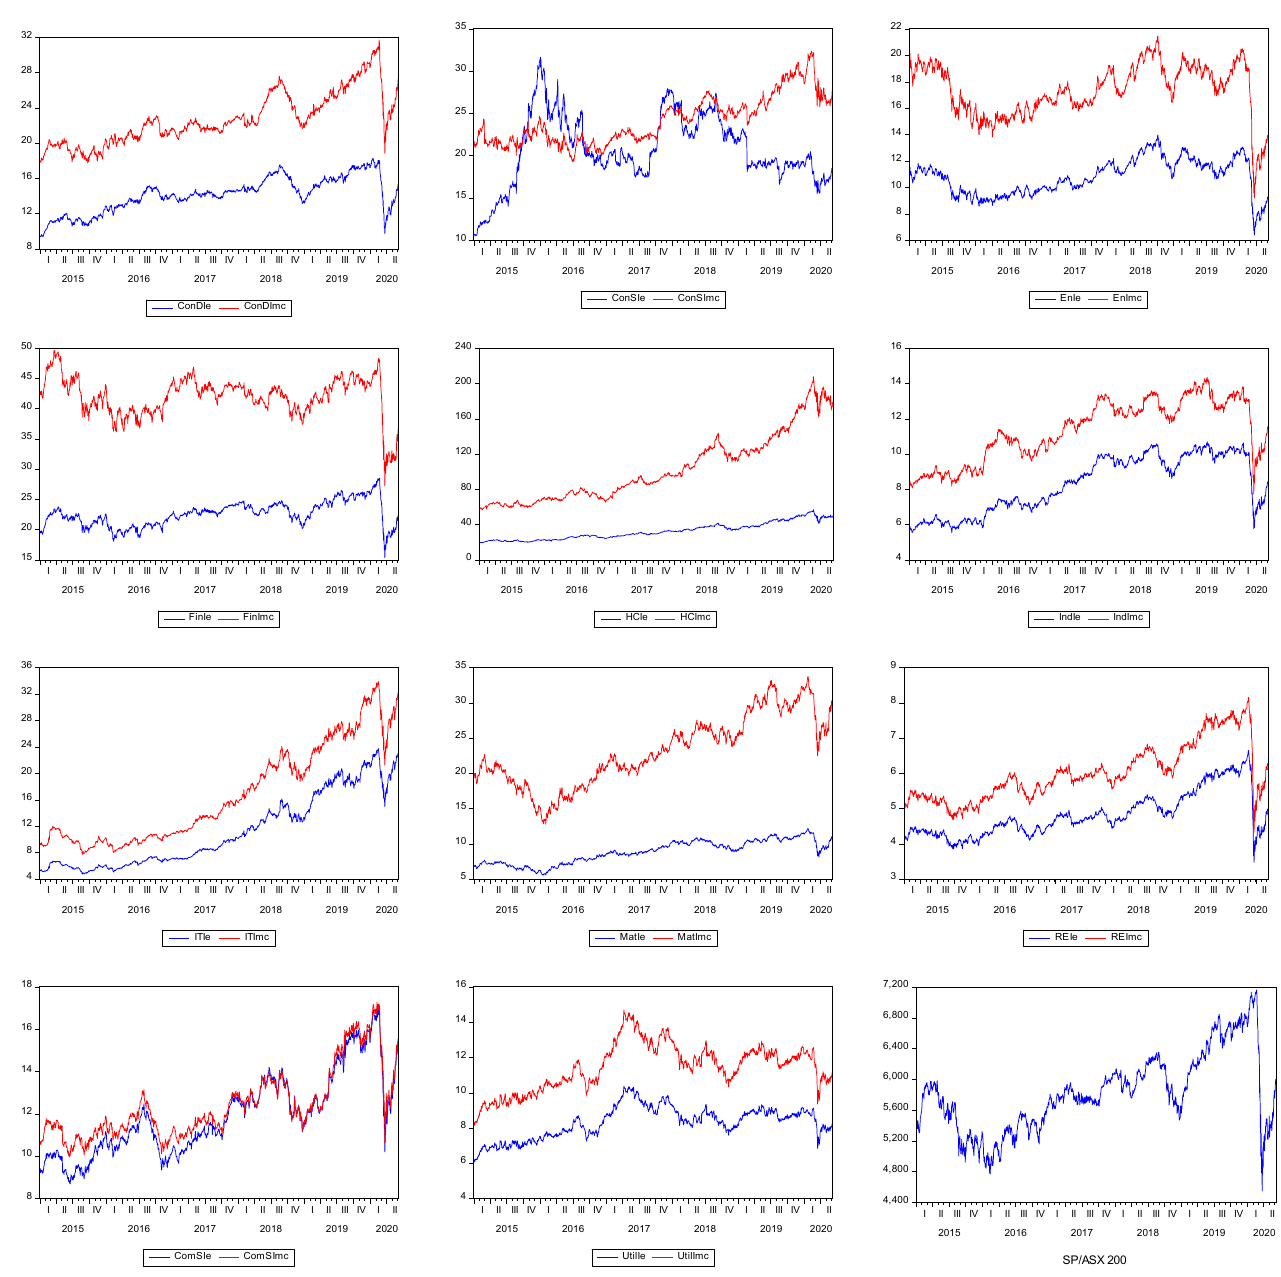
Figure 1. Price series of sector Indices and S&P/ASX 200. Note: For all graphs, the x -axis shows the time and the y -axis shows the return for each index. Equally weighted sector indices are shown in blue and market capitalization sector indices are shown in red.